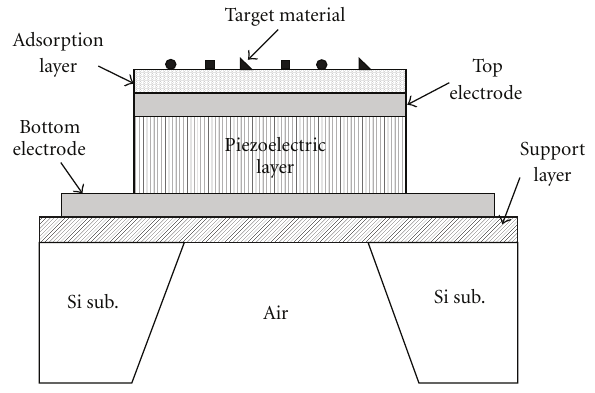
Figure 1: Cross-section structure of